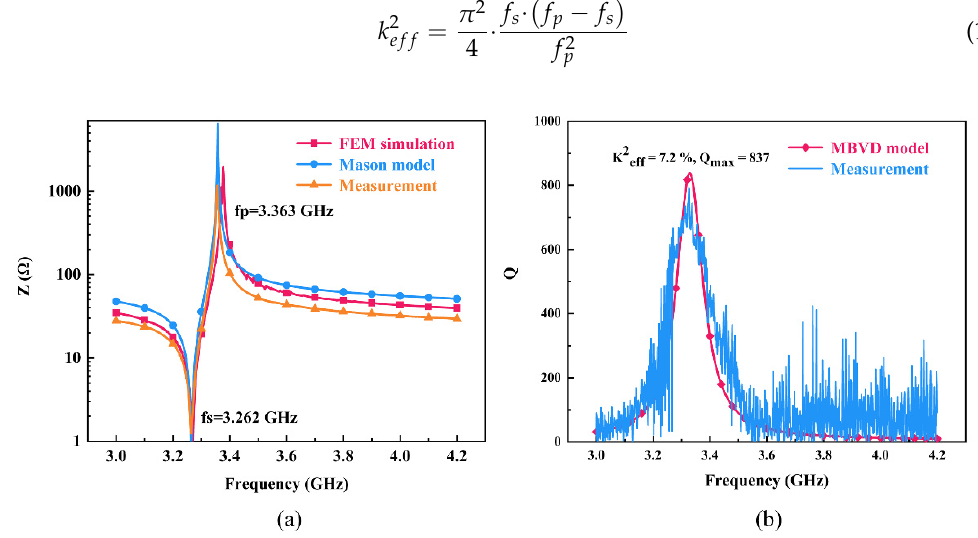
Figure 6. ( a ) Simulated impendence of resonator, ( b ) Q factor of MBVD fit model and measured data.